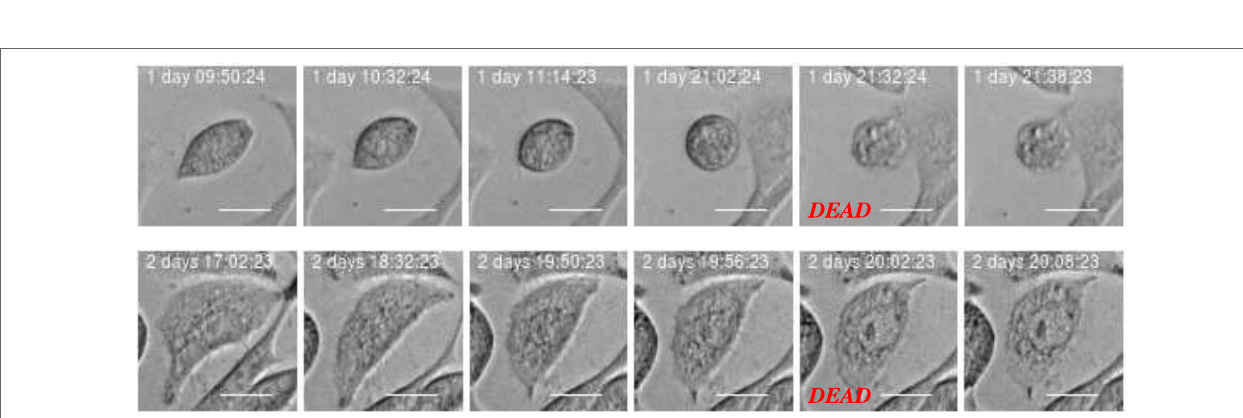
FigUre 4 | Example of cell death classified as “apoptosis-like” based of imagery recordings. Apoptotic-like cell death evidences cell shrinkage, dynamic membrane blebbing until the cell is systematically dismantled into membrane wrapped vesicles (apoptotic bodies). Green arrow points into apoptotic nuclear disintegration (nuclear extrusion). This morphology can facilitate automatic and objective classification and determination of time for cell death. Scale bar: 20 µm.